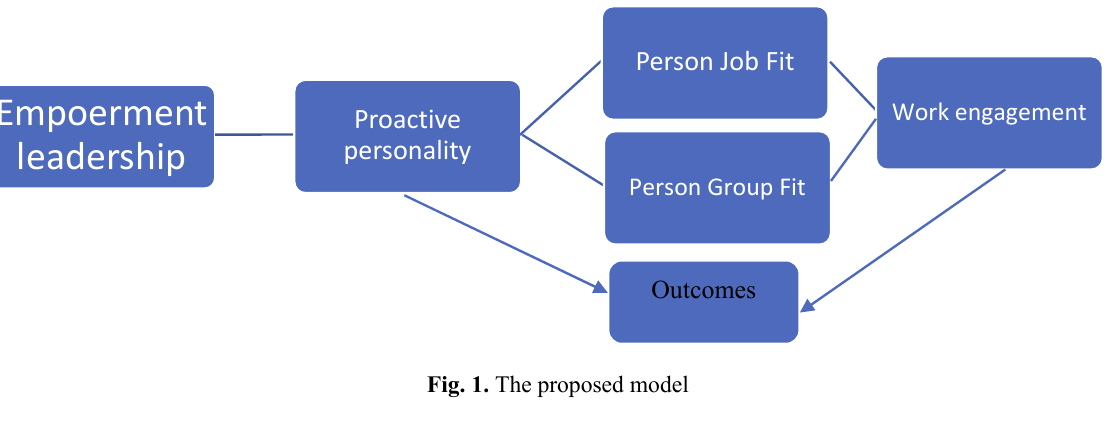
Fig. 1. The proposed